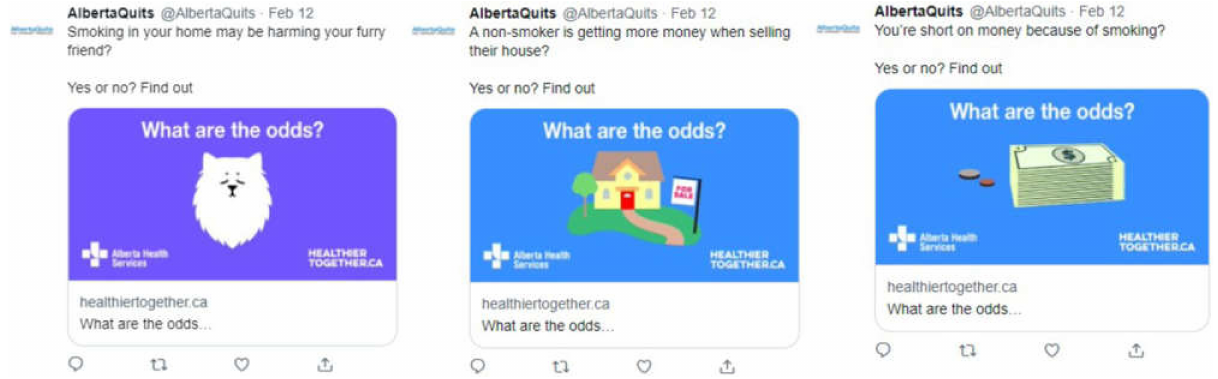
Figure 2. Examples of Single Images used in the Twitter Ad